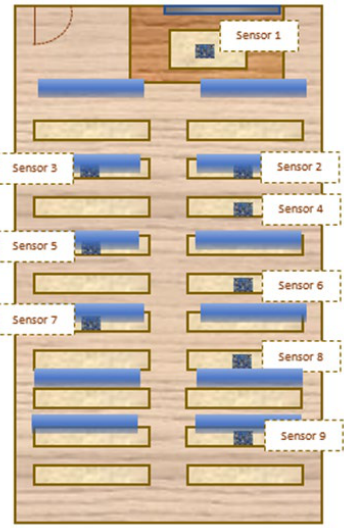
Figure 11. Diagram of the location of the artificial lighting system LEDs in the scale model of the